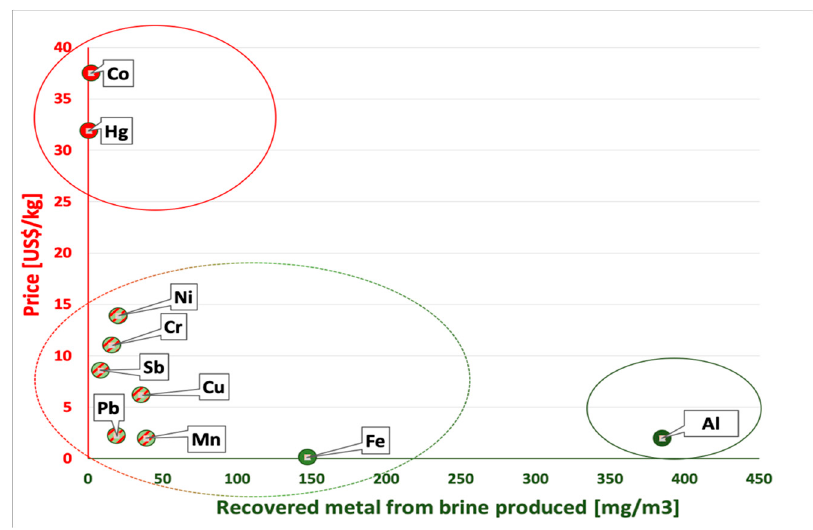
Figure 5. Recovered metals from brine MDC_3 system treatment [mg/m 3 ] versus their market price [$/kg]. Market prices are based on [35].